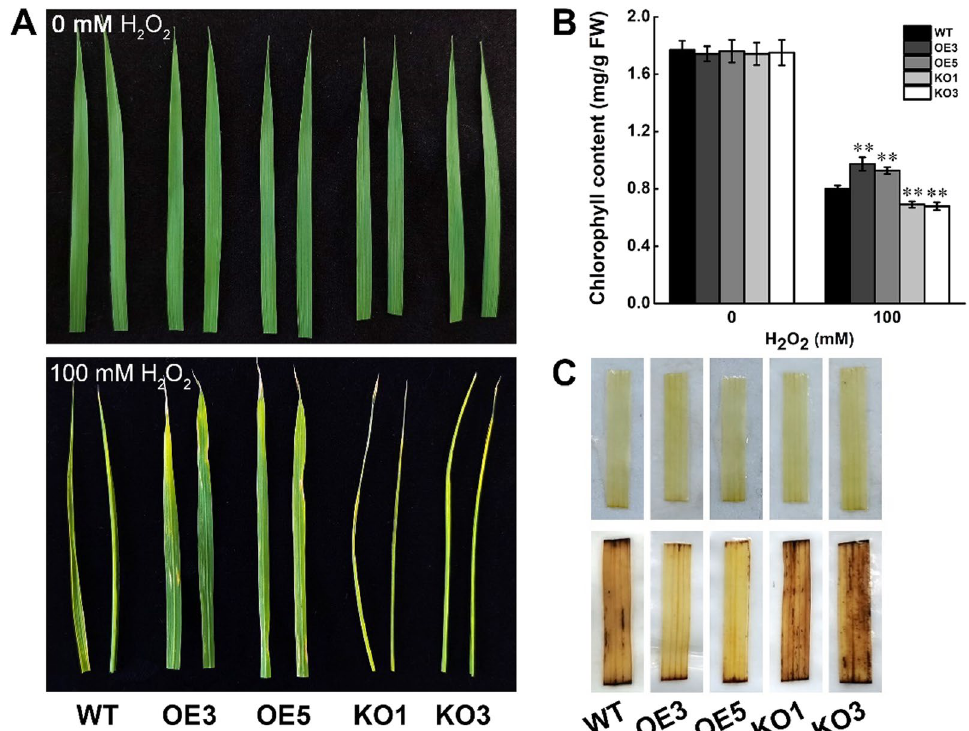
Fig. 6 Increased oxidative tolerance of STK overexpression plants. A Leaf phenotype of WT , STK- OE and STK- KO plants at the three-leaf stage under normal conditions or after 100 mM H 2 O 2 stress for 2 d. B Total chlorophyll contents of the WT , STK- OE and STK- KO plants under normal and H 2 O 2 stress conditions. FW, Fresh weight. Data are presented as mean and